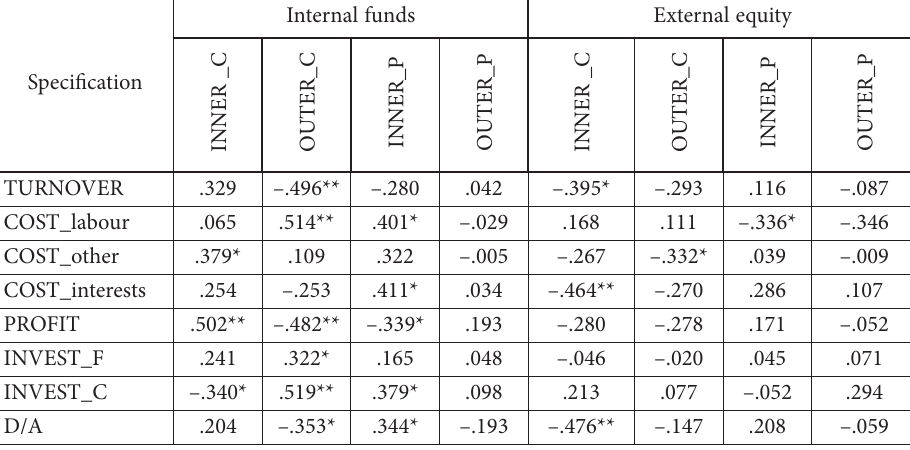
Table 4. The Pearson correlation coefficients for the relevance of equity financing and the proxies of SMEs financial